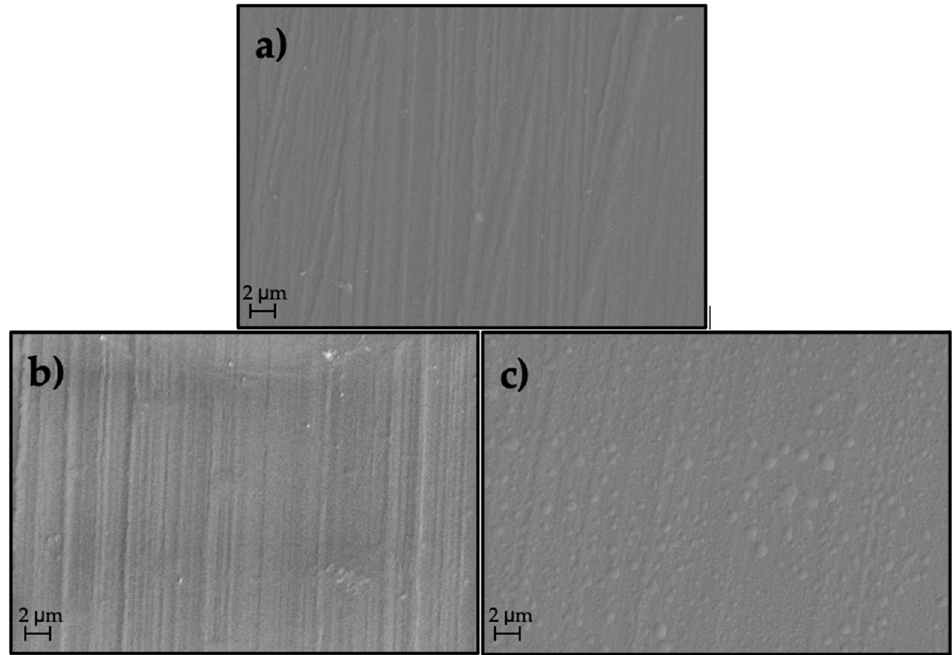
Figure 10. SEM micrographs of ( a ) PP, untreated, ( b ) PP, after β ¯ radiation treatment, and ( c ) PP, after plasma treatment.